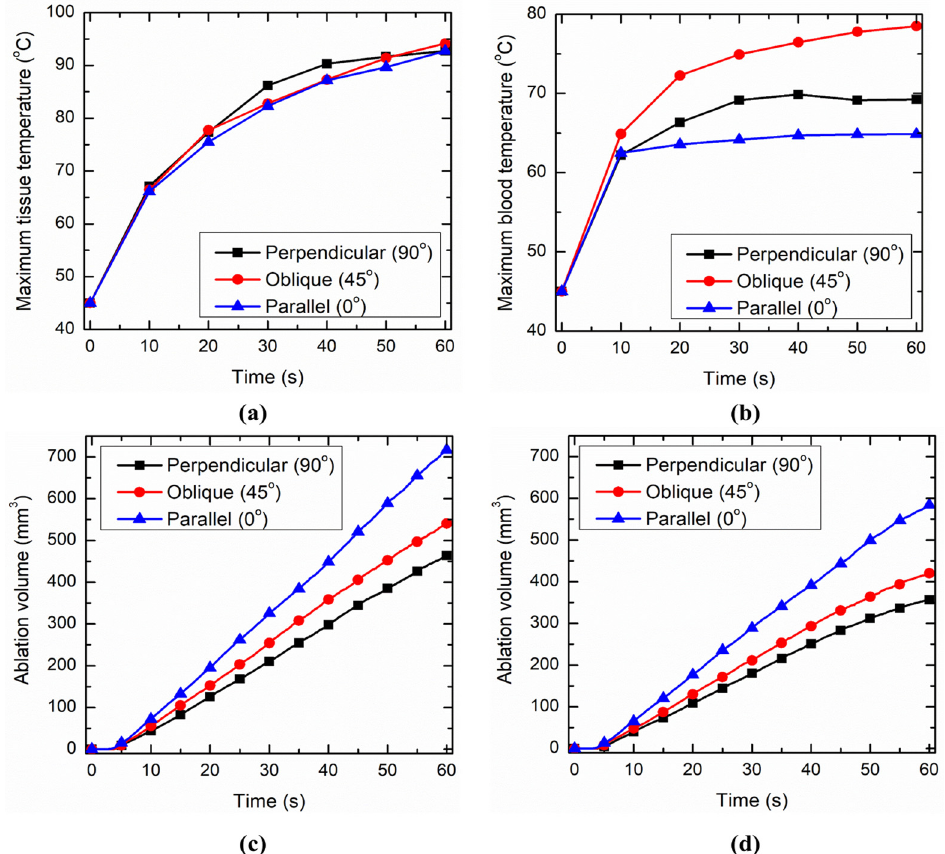
Figure 8. Temporal variation of: ( a ) maximum tissue temperature, and ( b ) maximum blood temperature for different orientations of electrodes. Comparison of ablation volumes predicted with different orientations of the electrodes for: ( c ) low blood flow rate, and ( d ) high blood flow rate conditions.